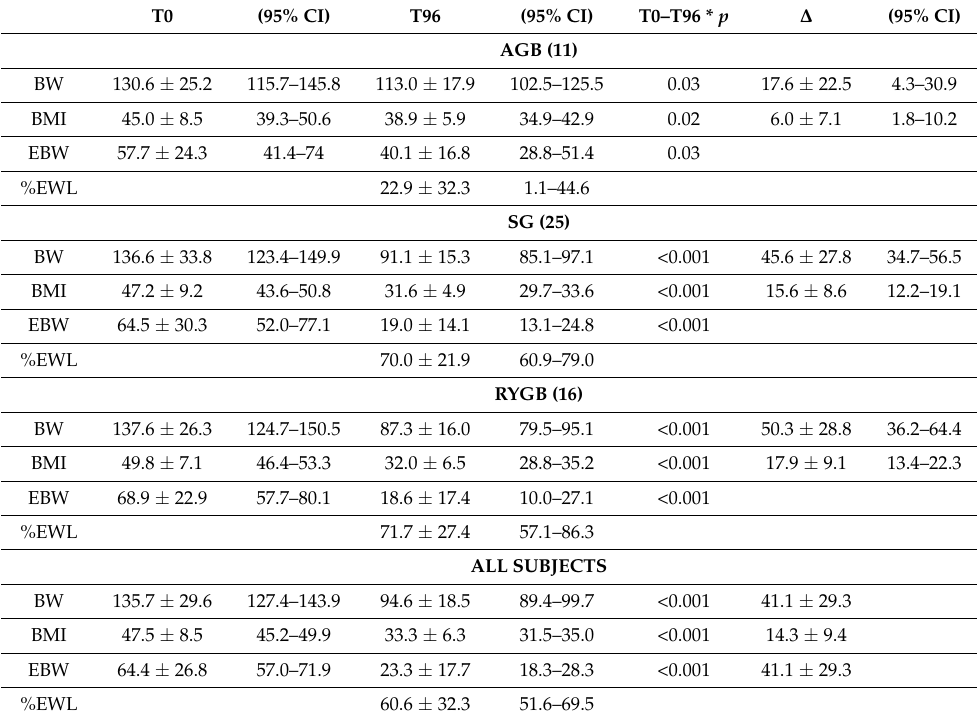
Figure 1. Percent weight loss (%WL) in patients undergoing AGB, SG and RYGB procedures 8 years after surgery. AGB: Laparoscopic adjustable gastric banding SG: Sleeve gastrectomy. RYGB: Roux-en- y gastric bypass. The ANOVA test for multiple comparisons was performed to compare the %WL of the three different surgeries over the 8 years ( p values: T3; 0.904, T6; 0.850, T12; 0.017, T24; 0.048, T36; 0.001, T48; 0.011; T60; 0.011, T72; 0.013, T84; 0.005; T96; 0.000006). Detailed data are presented in Table S2 in the Supplementary Material. Table 2. Postoperative changes (96 months) in body weight, BMI, and % excess body weight